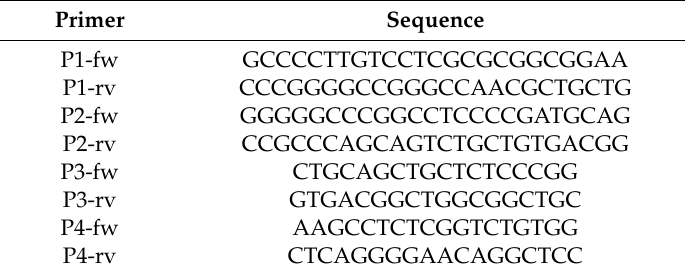
Table 1. Promoter primer sequences of β -catenin in di ff erent promoter sites using the HSPA1L antibody. Primer Sequence